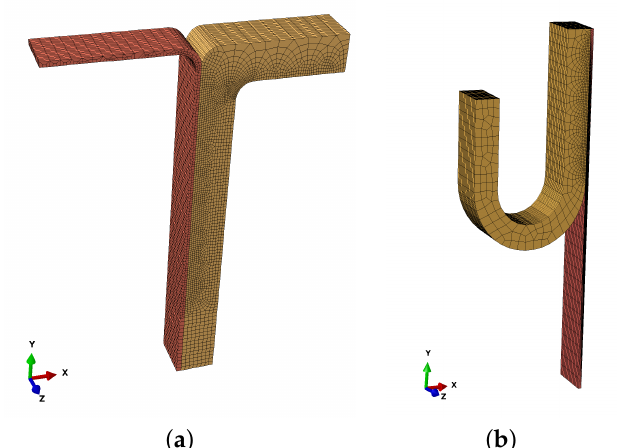
Figure 2. FE models of delamination experimental tests ( a ) Peel test and ( b ) Mixed test. Both models represent the IM separation. The thinner copper-coloured parts represent the intimal layer and the thicker brass-coloured parts, the media and